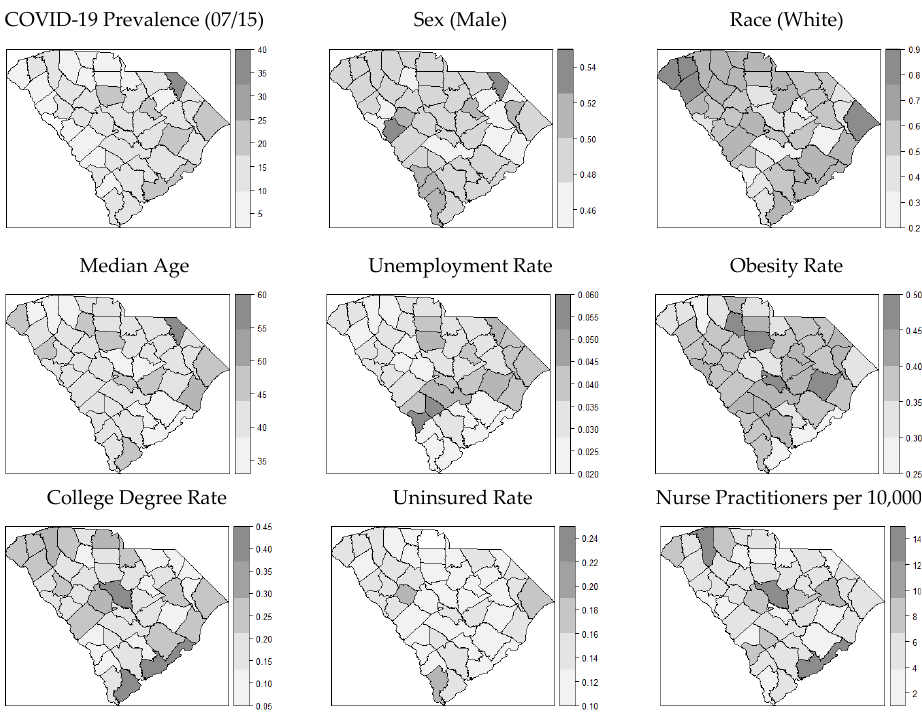
Figure 2. Distribution maps of the variables (in percentages) in the model.